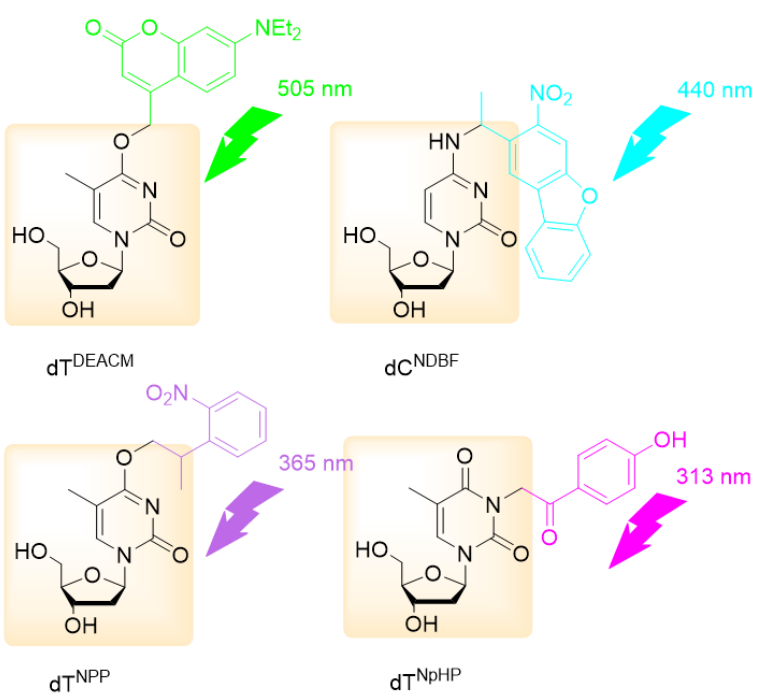
Figure 9. Four layer wavelength-selective uncaging approach for oligonucleotides using four different PPGs: 7-diethylaminocoumarin-4-yl)methyl (DEACM), 1-(3-nitrodibenzofuran-1-yl)ethyl (NDBF), 2-( o -nitrophenyl)propyl (NPP) and p -hydroxyphenacyl (pHP) (adapted from Rodrigues-Correia et al. [61]).